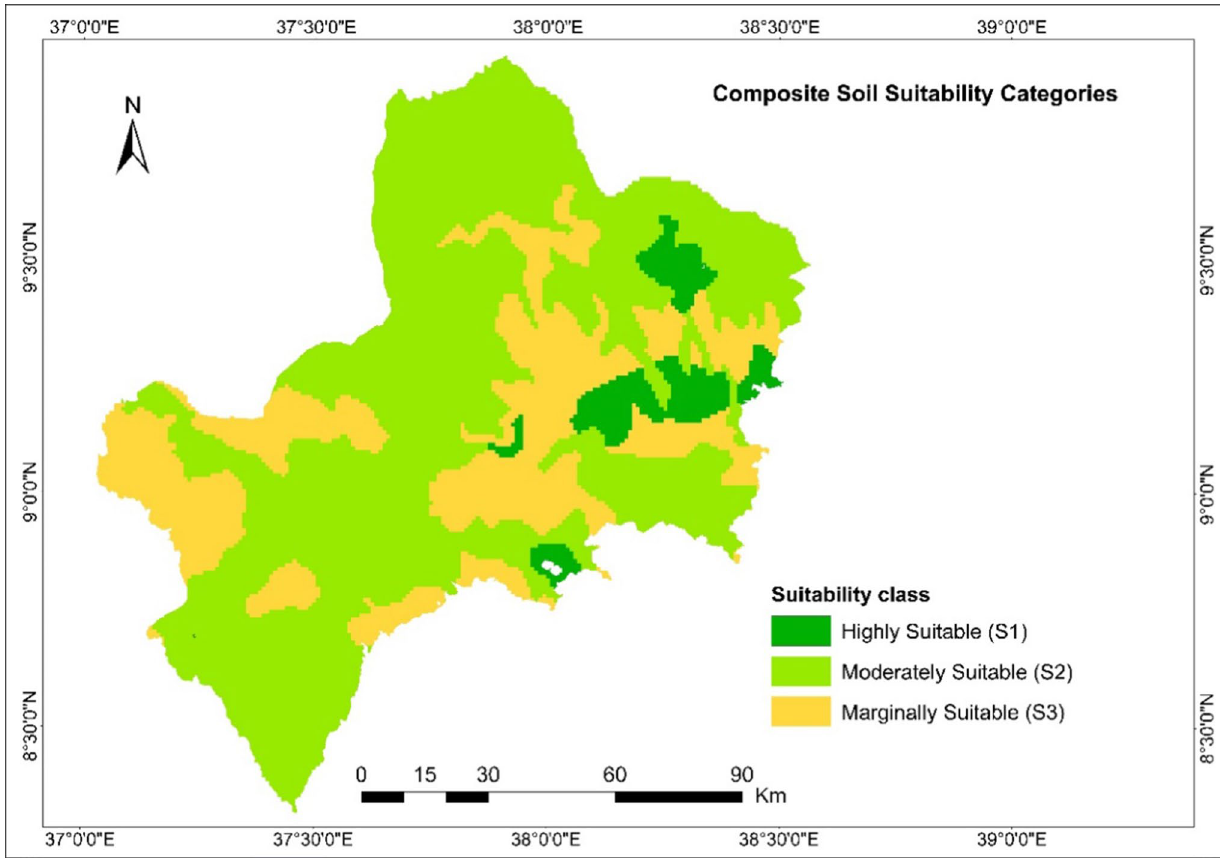
Fig. 13 The categories of composite soil suitability map Table 9 Land suitability factors’ weights